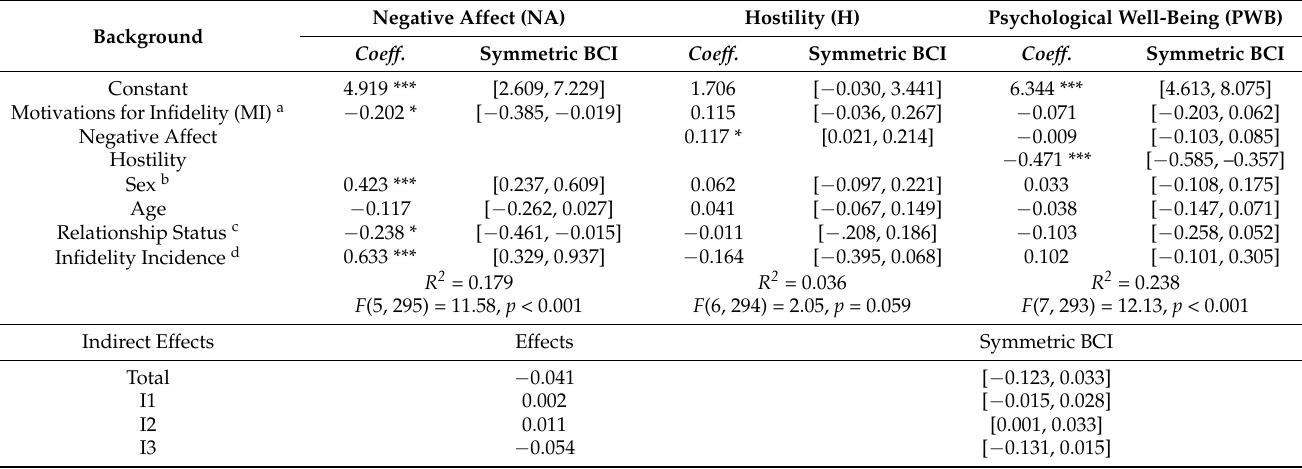
Table 1. Multiple mediation analysis of the motivations for infidelity (sexual dissatisfaction vs. emotional dissatisfaction), negative affect, and hostility on psychological